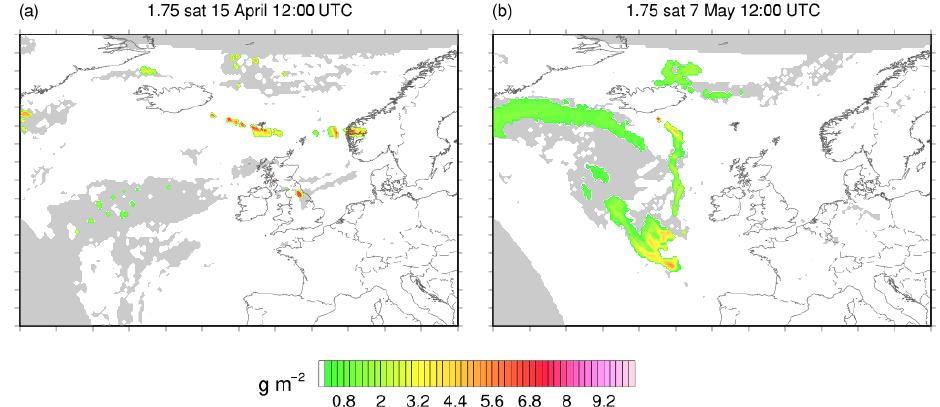
Figure 2. (a) and (b) SEVIRI satellite ash mass loading with a 1.75 lognormal size distribution on 15 April 2010 at 12:00UTC and on 7 May 2010 at 12:00UTC. The grey areas show the unidentified pixels, where the ash retrieval cannot distinguish whether or not there is ash.